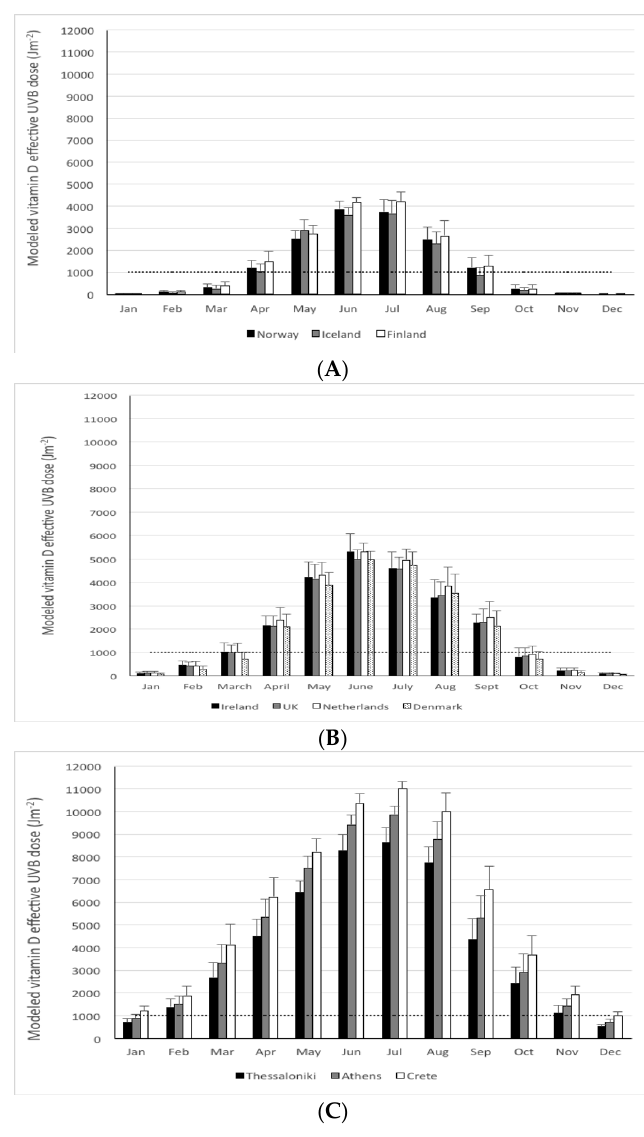
Figure 2. Mean modeled UVB doses effective for pre ‐ vitamin D 3 synthesis (Jm − 2 ) in Norway (mean of Oslo (60° N) and Tromsø (69° N)), Iceland (Reykjavik (64° N)) and Finland (60–70° N) ( A ); Ireland (51–54° N), the UK (50–59° N), Netherlands (Amsterdam, (52° N)), and Denmark (mean of Copenhagen and Aarhus (56° N)) ( B ); and Thessaloniki (40° N), Athens (37° N) and Crete (35° N) ( C ) on a monthly basis in a typical year (mean of 2003–2012). Dotted line reflects a threshold of 1000 Jm − 2 as a guide to a dose below which dermal synthesis of pre ‐ vitamin D 3 is relatively low.